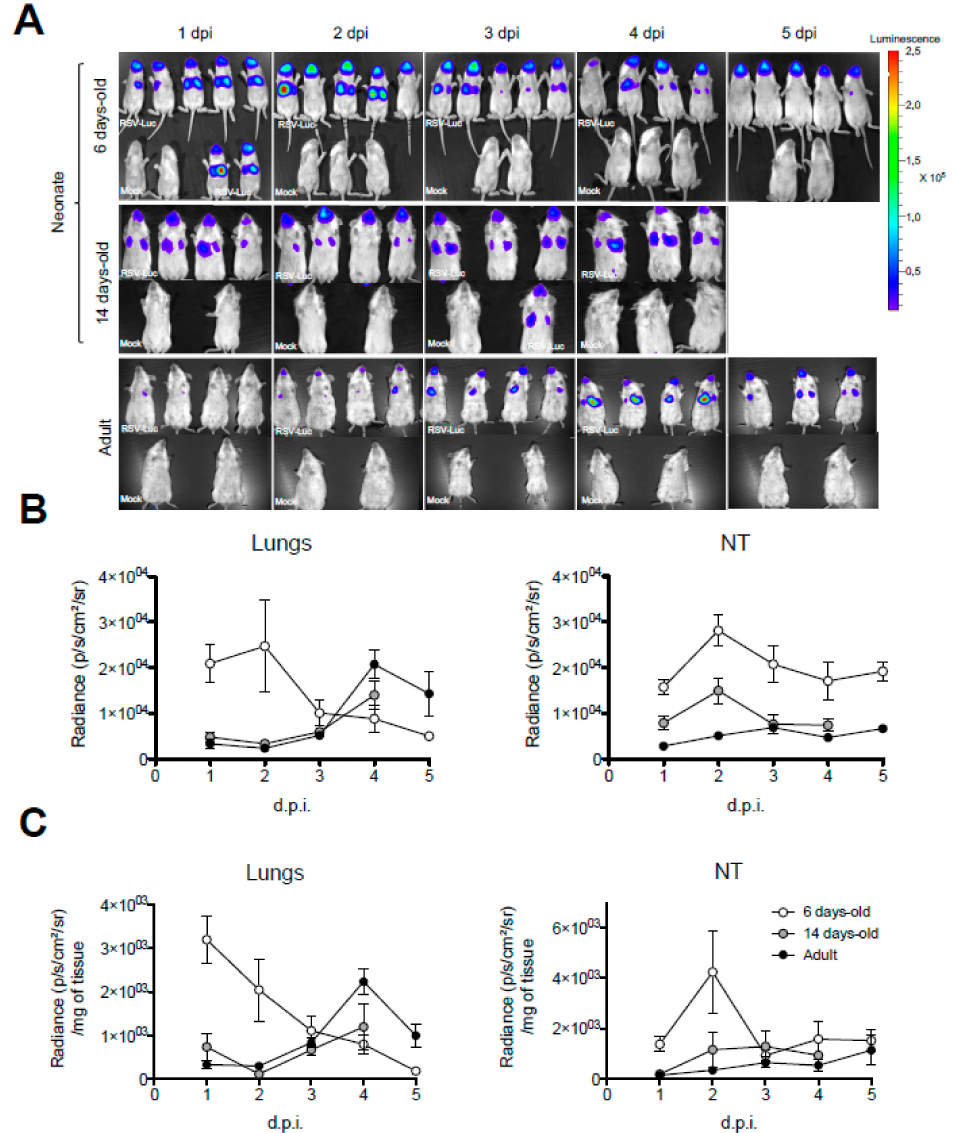
Figure 2. Age-dependent RSV replication kinetic in BALB / c mice. Six day-old or 14 day-old neonates and 8 week-old adult mice were infected i.n. with RSV-Luc (1.75 × 10 6 pfu / mL, 10 µ L / neonate, 50 µ L / adult). ( A ) At each time point after infection, mice received luciferin (1.5 mg under 50 µ L, administrated ip for neonates and in for adults) and luciferase activity was visualized in the IVIS-200 imaging system. ( B ) Quantification of luciferase activity in the lungs and NT of living mice (radiance in photon / s / cm 2 / sr) or ( C ) in lung and NT homogenates (radiance in photon / s / cm 2 / sr / mg of tissues). Results are expressed as mean of individual ± SEM (one representative experiment of two with n = 5 to 8 mice /